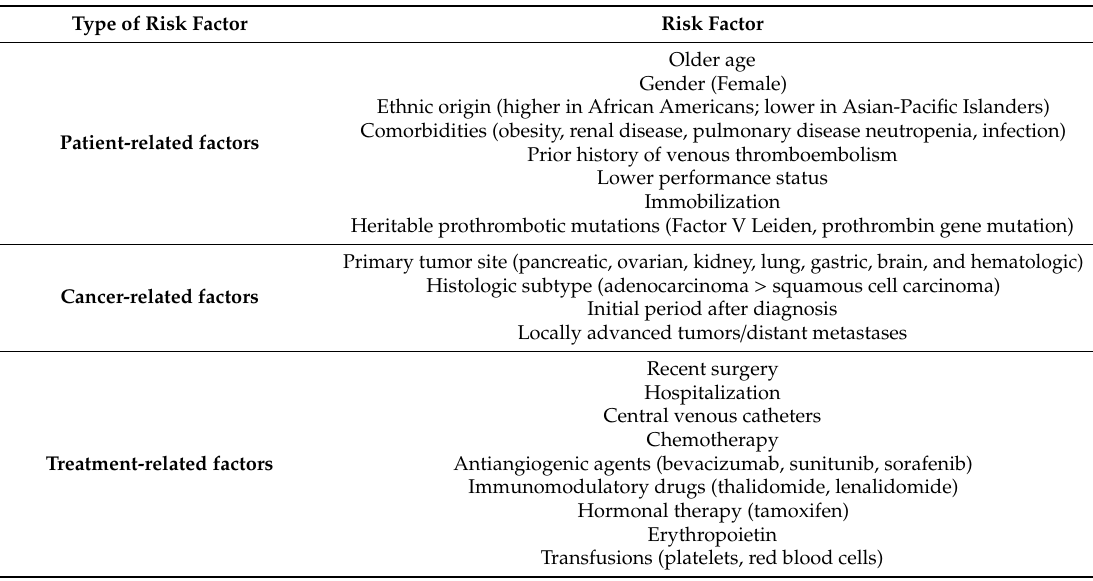
Table 1. Risk factors for venous thromboembolism in cancer patients.